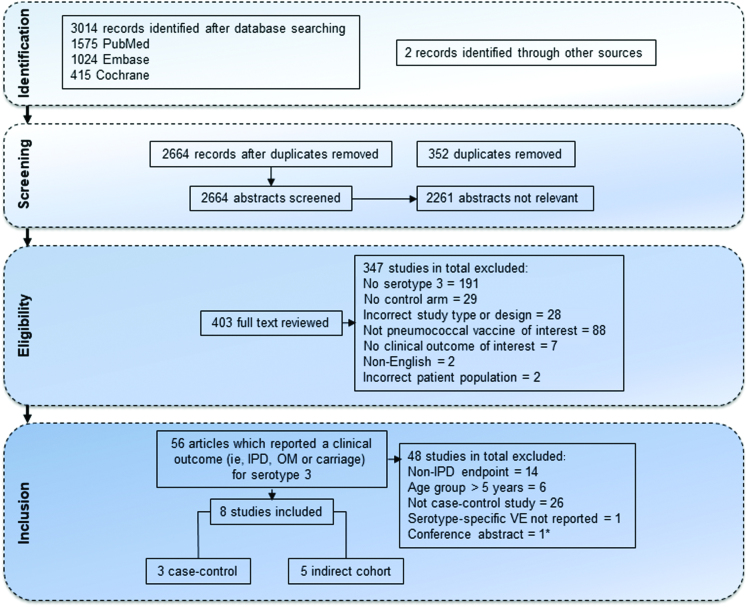
Flowchart of publications included and excluded for this review. Exclusion criteria included studies conducted in nonhuman subjects, with no control arm or reference group (ie, a single-arm study), with incomplete description (usually letters, editorials, or comments), no use of pneumococcal vaccine, or no clinical outcome of interest (eg, serotype-specific antibiotic resistance).  Abbreviations: IPD, invasive pneumococcal disease; OM, otitis media; VE, vaccine effectiveness. *Serotype 3 vaccine effectiveness estimate was later published in study 4.